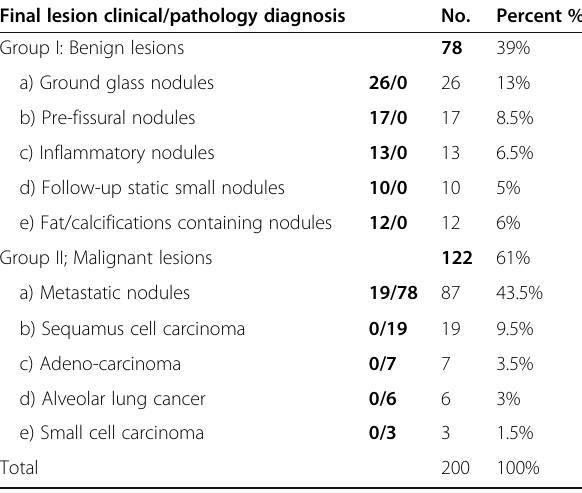
Table 3 Final clinico-pathological diagnosis results of the all studied nodular lesions (no. = 200)